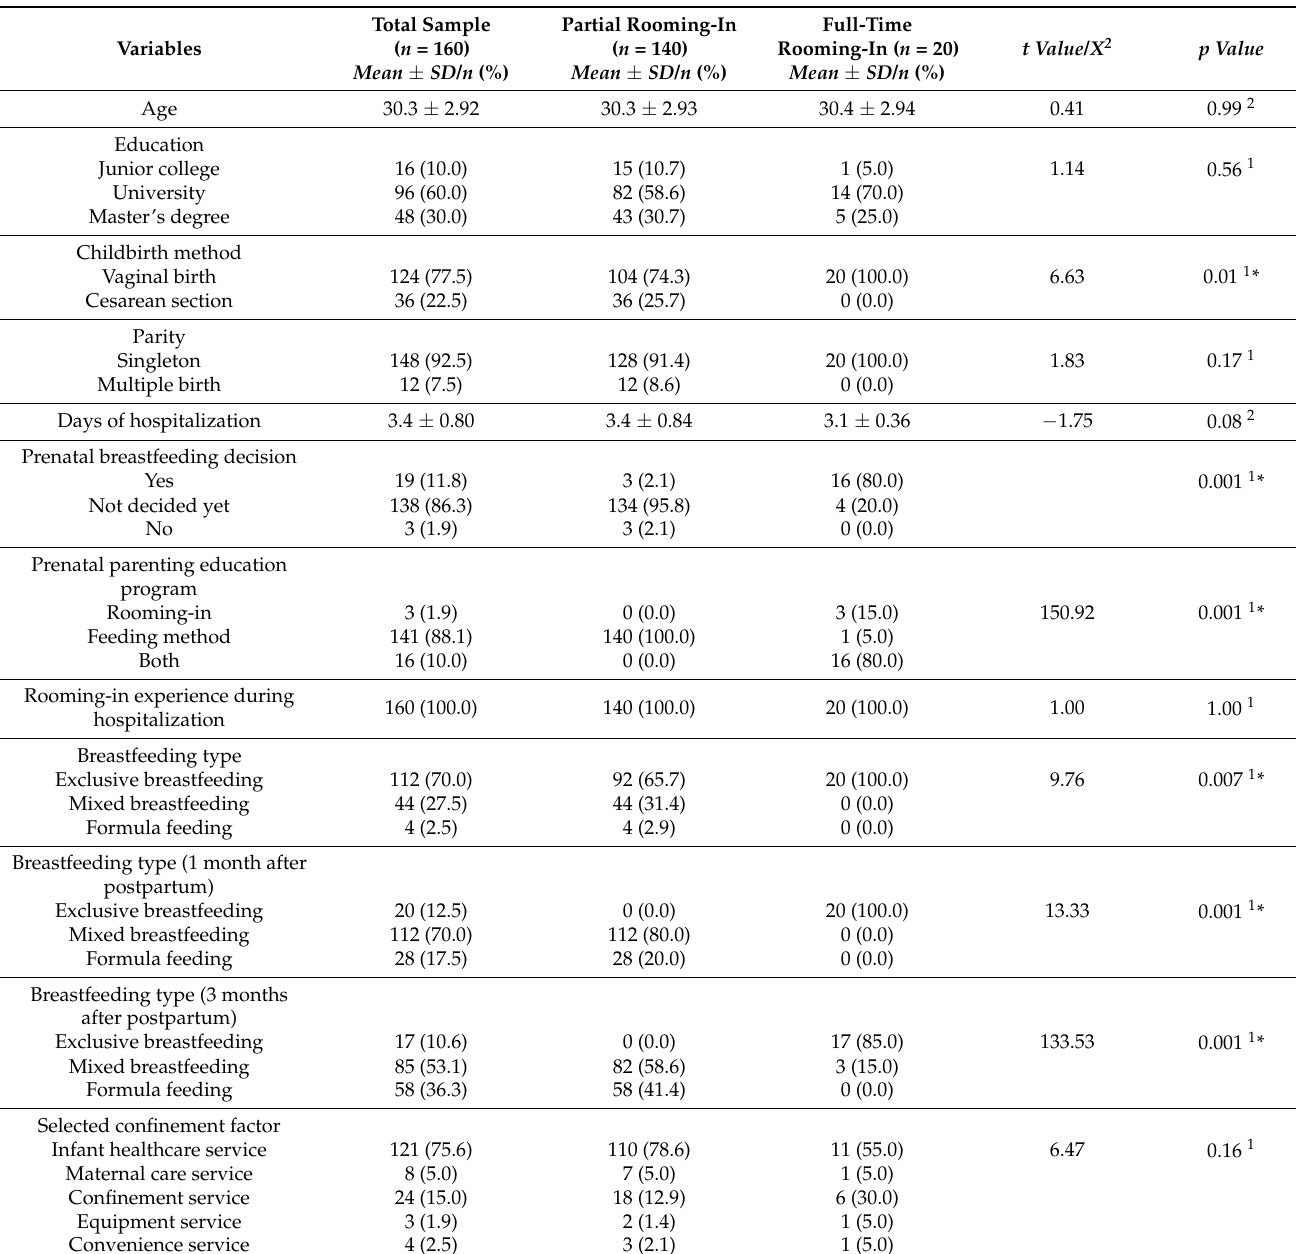
Table 1. Characteristics of participants and comparison between partial rooming-in and full-time rooming-in participants ( n